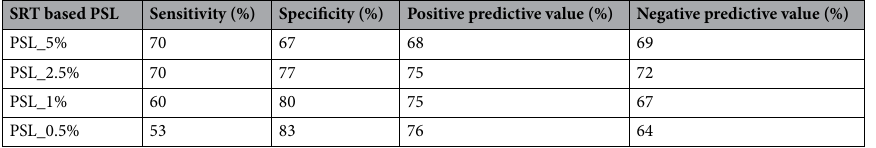
Table 6. Sensitivity and specificity with positive and negative predictive values of PSLs based on SRT at different levels. PSL, probability score limits; SRT, saccadic reaction time.